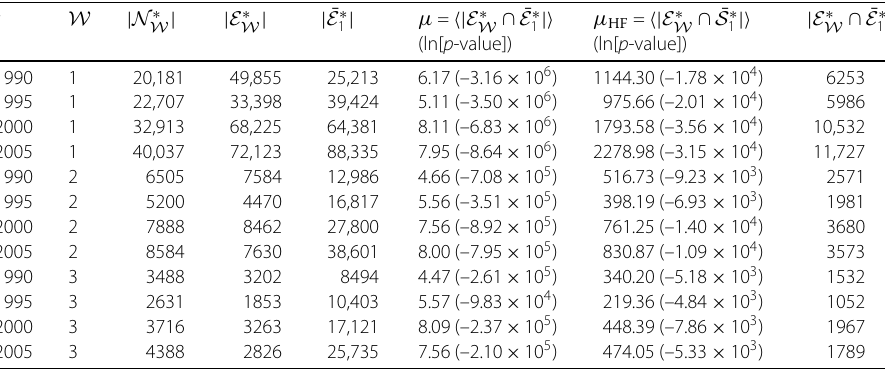
Table 3 Table for test of threshold method for the cases that ignore or take into account the firm heterogeneity ( HF ). The table only includes (cid:2) t = 2, as other values of (cid:2) t have only a minor effect on the probability densities ℘ , ℘ ( HF ) , and ℘ W . We show a selection of years for each of the three values of W = 1,2,3. Note that the p -values are exceedingly small for both